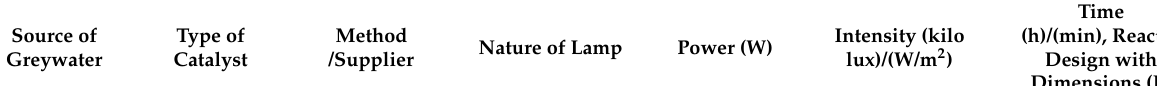
Table 4. Conditions and efficiency of TiO 2 catalyst for photocatalytic treatment of